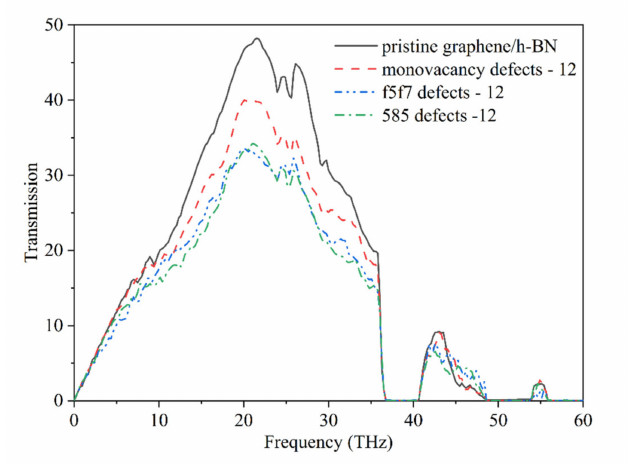
Figure 5. Phonon transmission in the near-interface regions of pristine graphene/h-BN and graphene/h-BN with twelve defects.